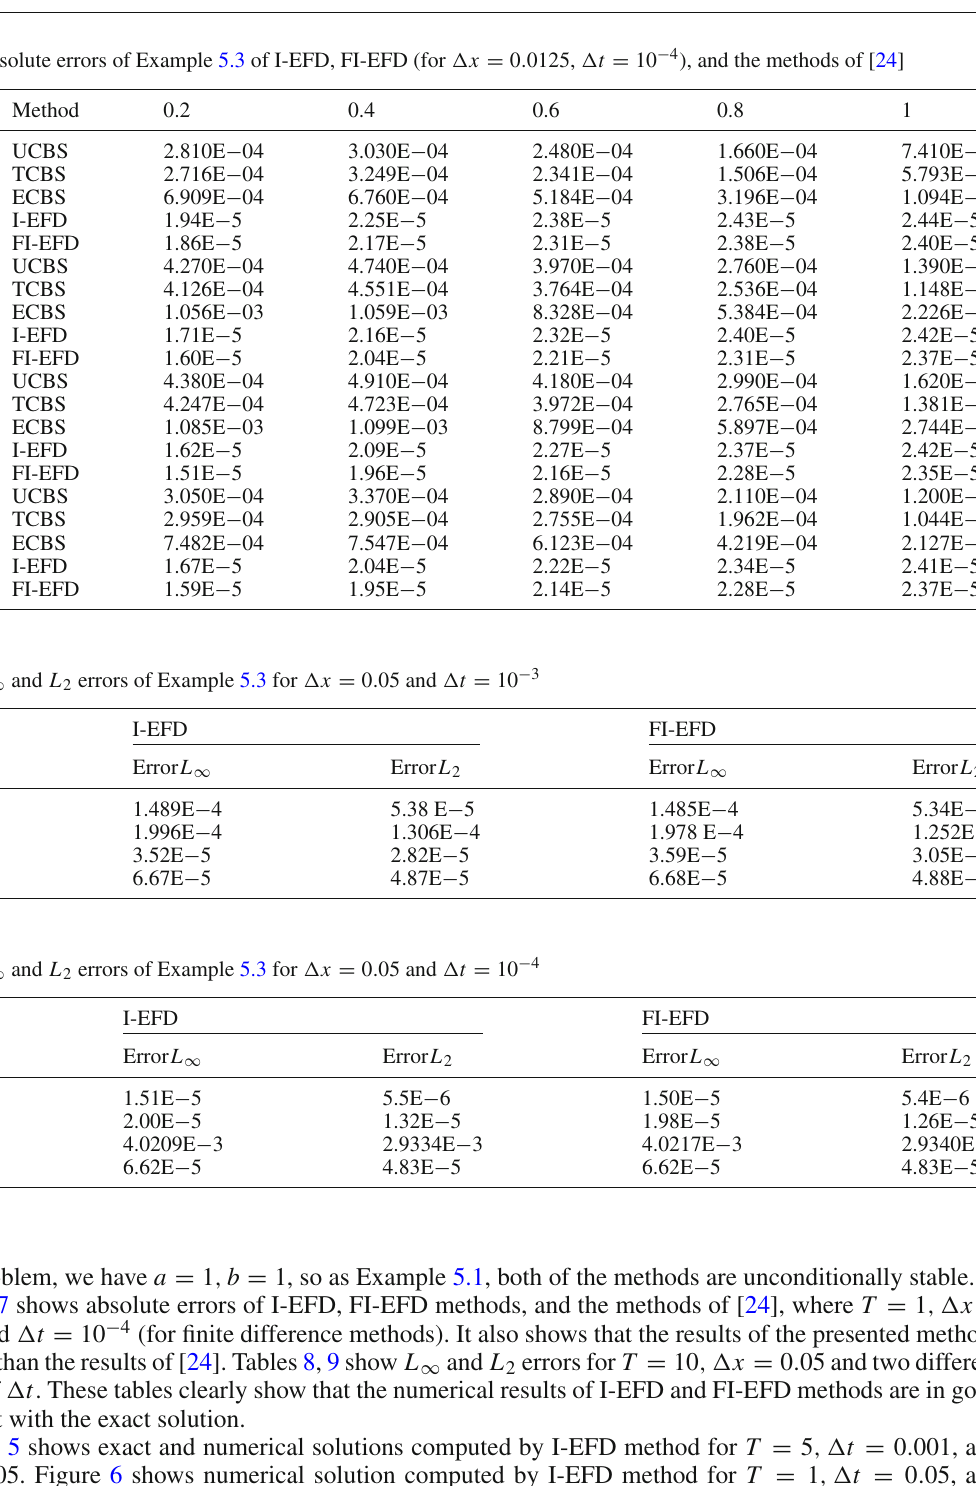
Table 7 Absolute errors of Example 5.3 of I-EFD, FI-EFD (for (cid:2) x = 0 . 0125, (cid:2) t = 10 − 4 ), and the methods of [24] x / t 0 . 2